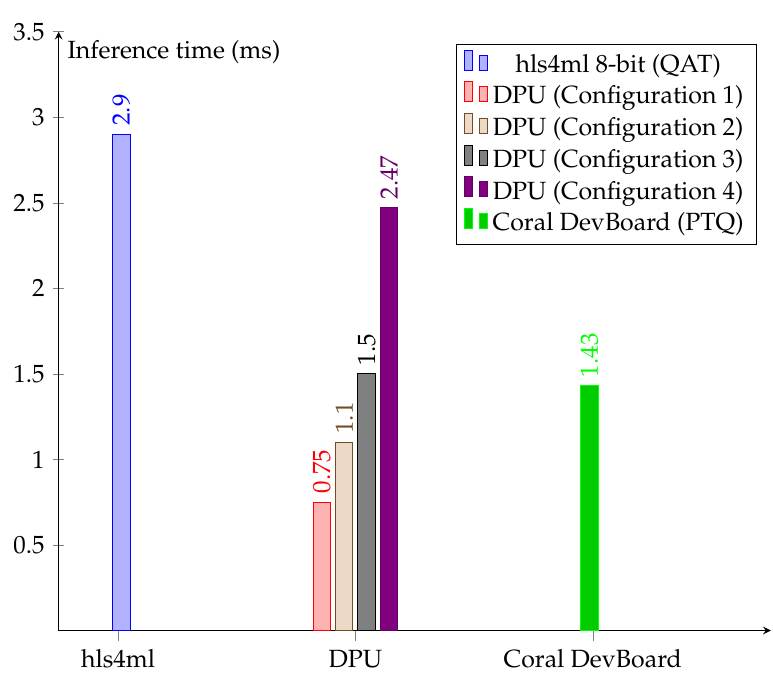
Figure 12. Inference time (in ms) of hls4ml , different configurations of the DPU and the Coral DevBoard with the TPU.